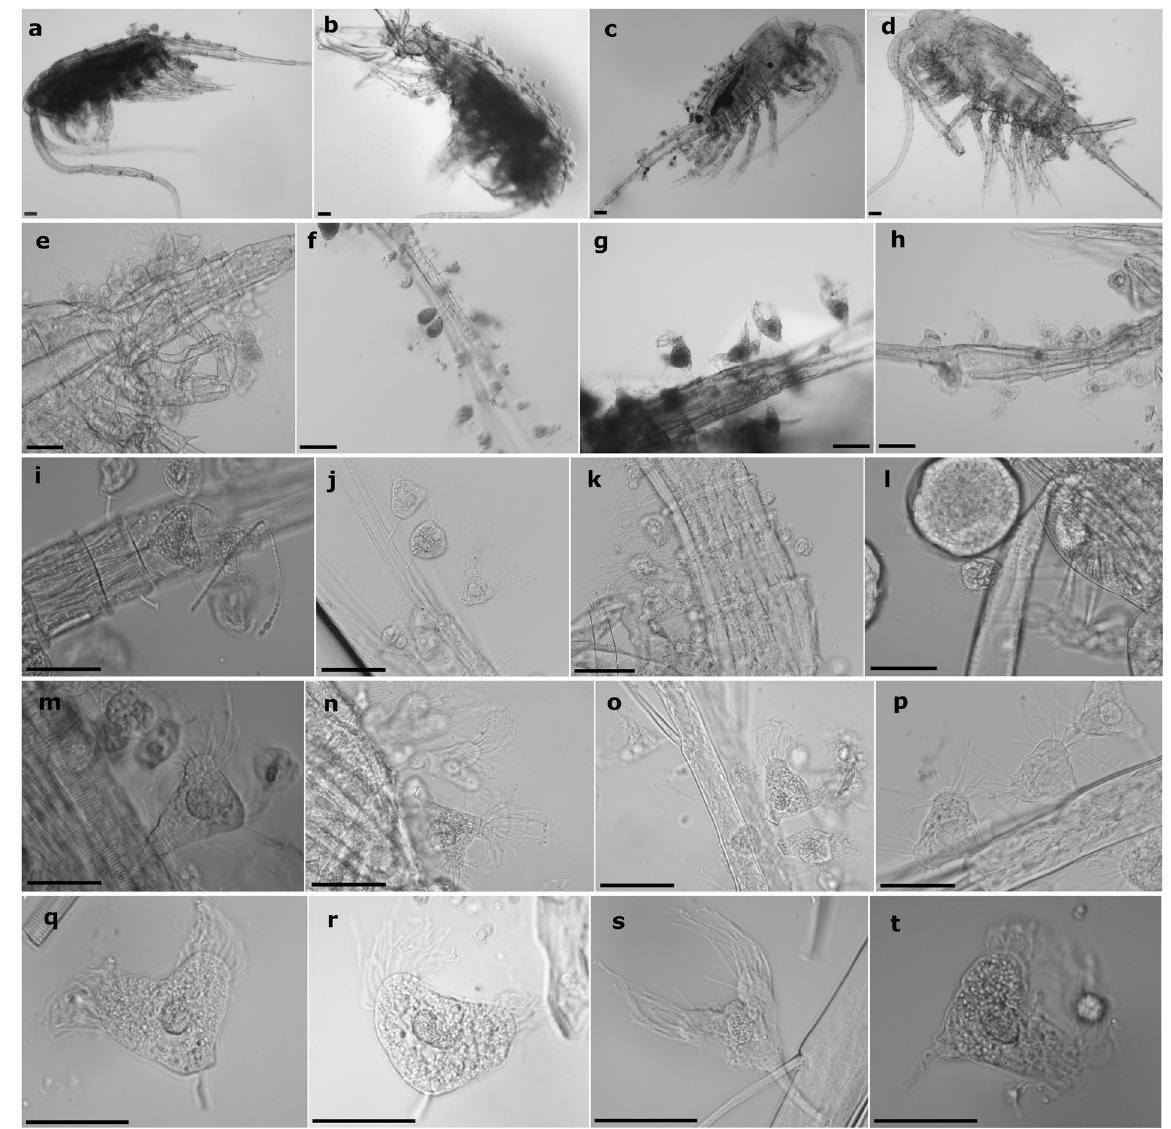
Figure 2. Tokophrya isolated from the assessed regions: NE Poland—F, J, K, and P; NW Poland—B, D, E, G, L, M, N, O, and S; Russia—C and T; Scandinavia—A, H, I, Q, and R. Scale bar: 50 µ